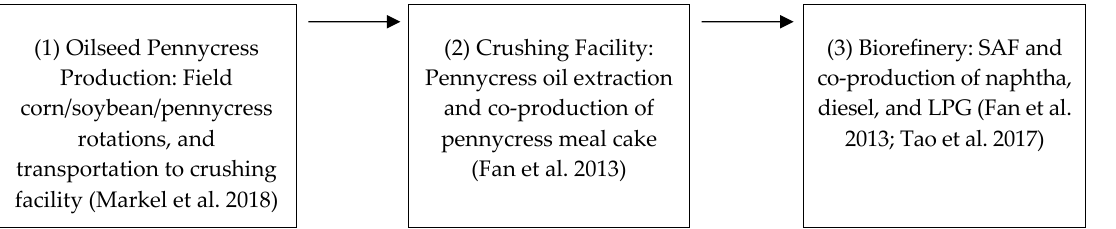
Figure 1. Major enterprises in pennycress sustainable aviation fuels (SAF) production.